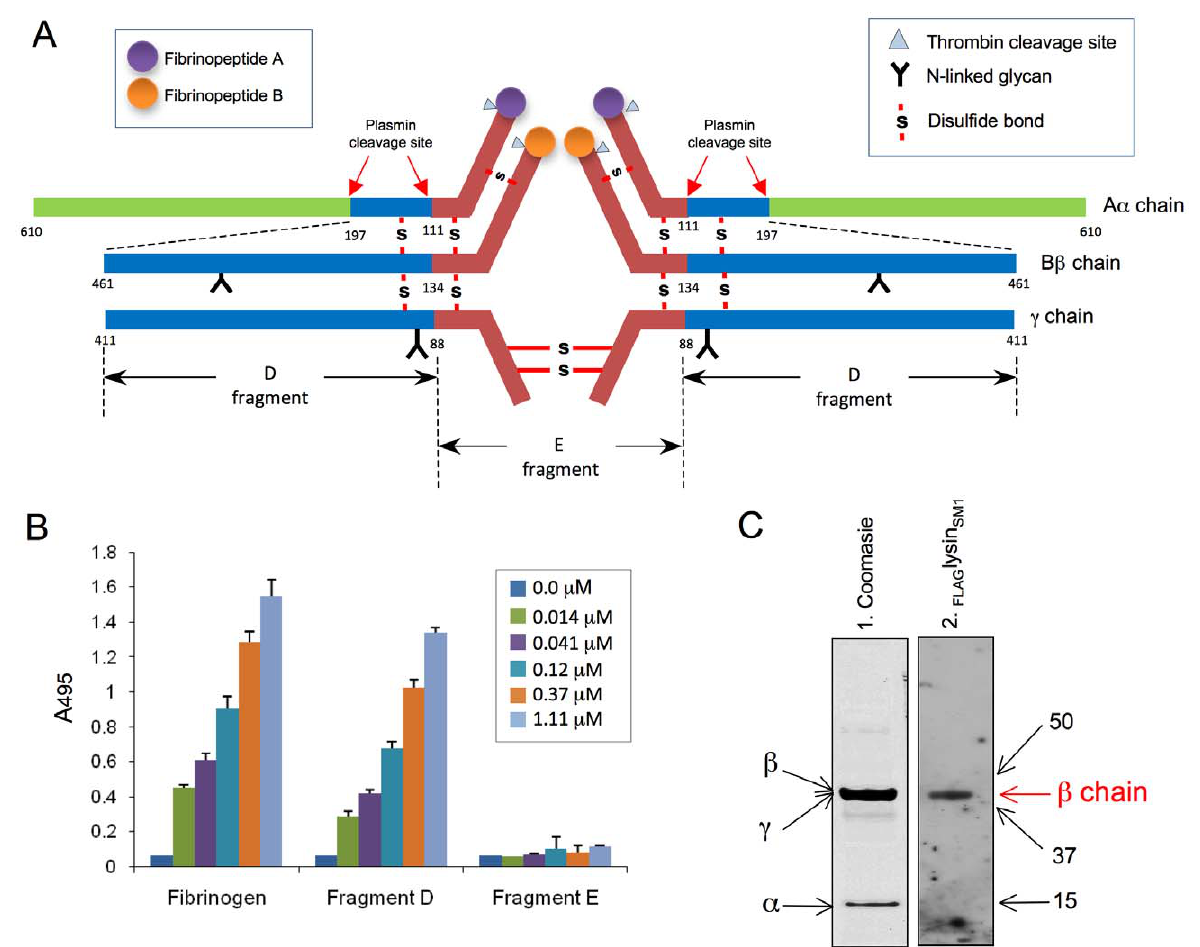
Figure 5. Binding of FLAG lysin SM1 to immobilized fibrinogen fragments D and E. (A) Schematic diagram of human fibrinogen. The A a , B b , and c chains, major disulfide linkages, and plasmin cleavage sites are shown. (B) Indicated concentrations of FLAG lysin SM1 were incubated with immobilized human fibrinogen, fibrinogen fragment D, or fragment E. Bound FLAG lysin SM1 was detected with anti-FLAG antibody. Bars indicate the means ( 6 S.D.). (C) Fibrinogen fragment D was separated by SDS-PAGE under reducing conditions and stained with Coomassie blue (panel 1) or transferred onto nitrocellulose membrane and incubated with FLAG lysin SM1 (5 m g/ml). The bound proteins were detected with anti-FLAG antibody (Lane 2). Arrows indicate positions of A a , B b , and c chain fragments. Numbers indicate molecular mass